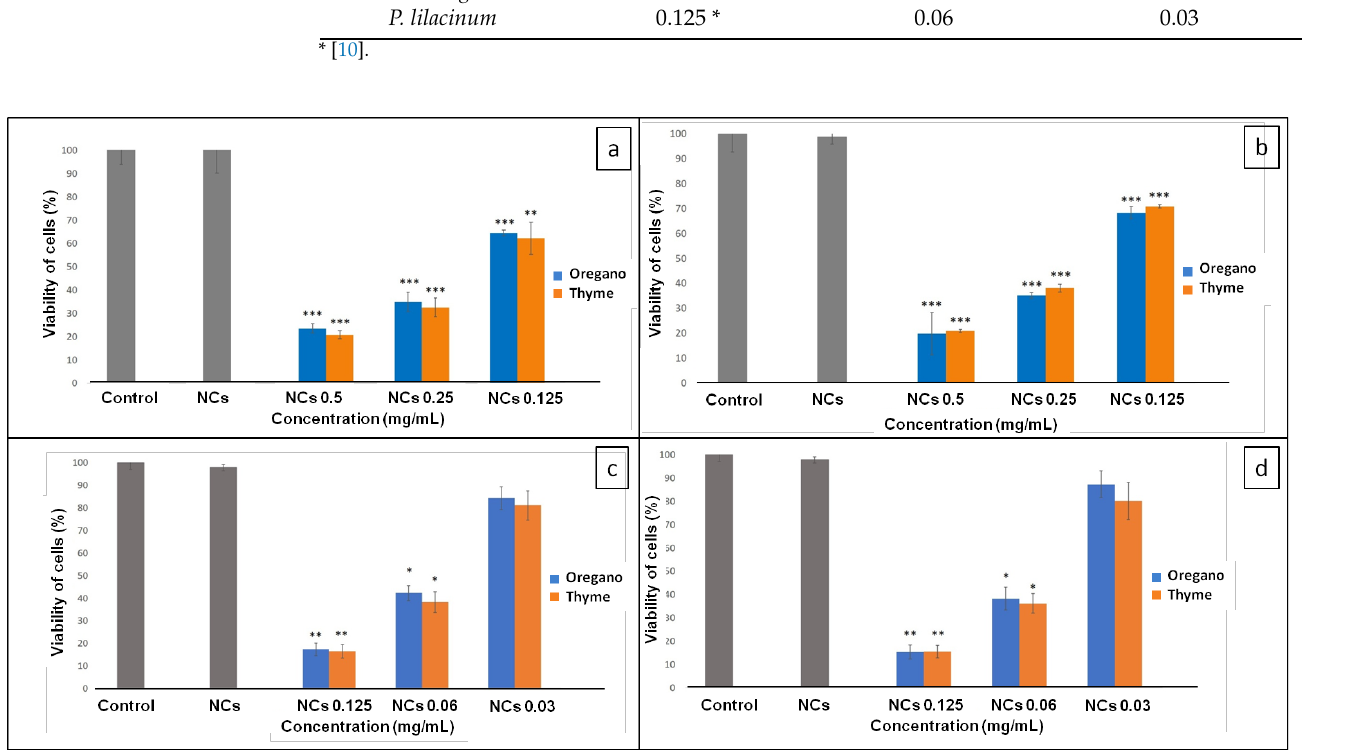
Figure 1. Viability of cells in the presence of encapsulated oregano and thyme EOs: ( a ) P. vancou- verensis ; ( b ) Flavobacterium sp.; ( c ) P. eryngii ; ( d ) P. lilacinum . Where * is p < 0.05; ** is p < 0.01; *** is p < 0.001. Table 1. MIC and sub-MIC values of EO-NCs against P. vancouverensis , Flavobacterium sp., P. eringii , P. lilacinum